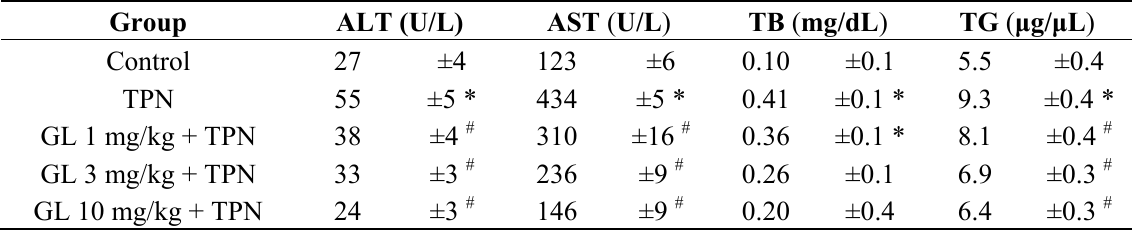
Table 1. Effect of GL on the serum levels of liver enzymes, triglyceride and total bilirubin in total parenteral nutrition (TPN) rats. Group ALT (U/L) AST ( U/L ) TB ( mg/dL ) TG ( μ g/ μ L ) Control 27 ±4 123 ±6 0.10 ±0.1 5.5 ±0.4 TPN 55 ±5 * 434 ±5 * 0.41 ±0.1 * 9.3 ±0.4 * GL 1 mg/kg + TPN 38 ±4 # 310 ±16 # 0.36 ±0.1 * 8.1 ±0.4 # GL 3 mg/kg + TPN 33 ±3 # 236 ±9 # 0.26 ±0.1 6.9 ±0.3 # GL 10 mg/kg + TPN 24 ±3 # 146 ±9 # 0.20 ±0.4 6.4 ±0.3 # Values represent the mean ± SD ( n = 6); * p < 0.05 ( versus control group); # p < 0.05 (between TPN